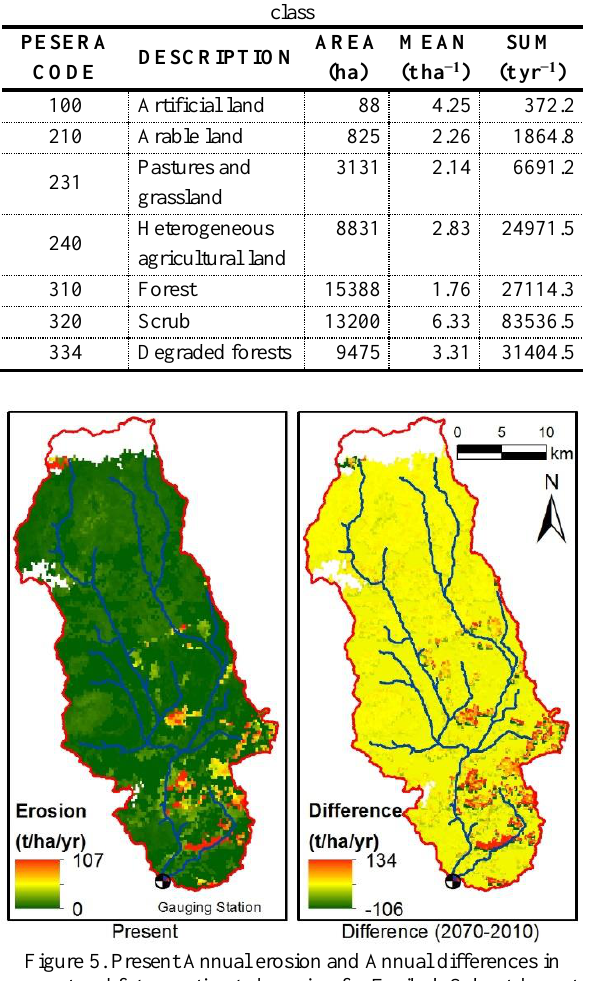
Table 1. Annual erosion estimations for PESERA Land Cover